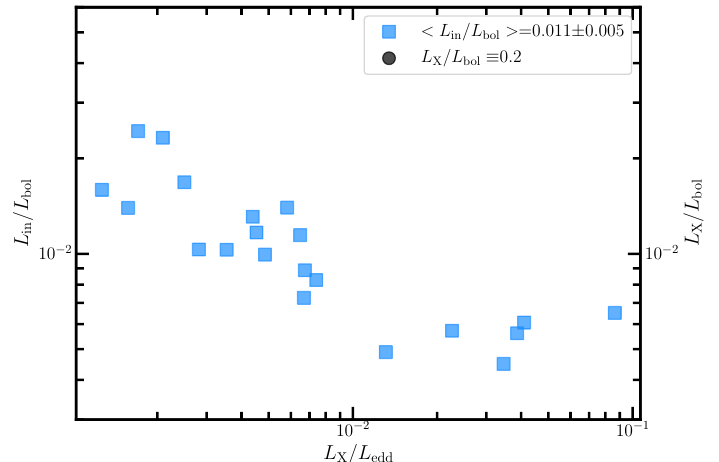
Figure 5. Distribution of the inner-disk luminosity to bolometric luminosity ratio L in / L bol versus 1–10 keV X-ray luminosity (in Eddington units) in the ‘outlier’ track of MAXI J1348-630 (in the right y-axis, the 1–10 keV X-ray luminosity to bolometric luminosity ratio is L X / L bol ). As labelled in the plot, the blue squares represent L in / L bol ; L X / L bol is set to 0.2, i.e., the X-ray bolometric correction factor f X = 5 [58].